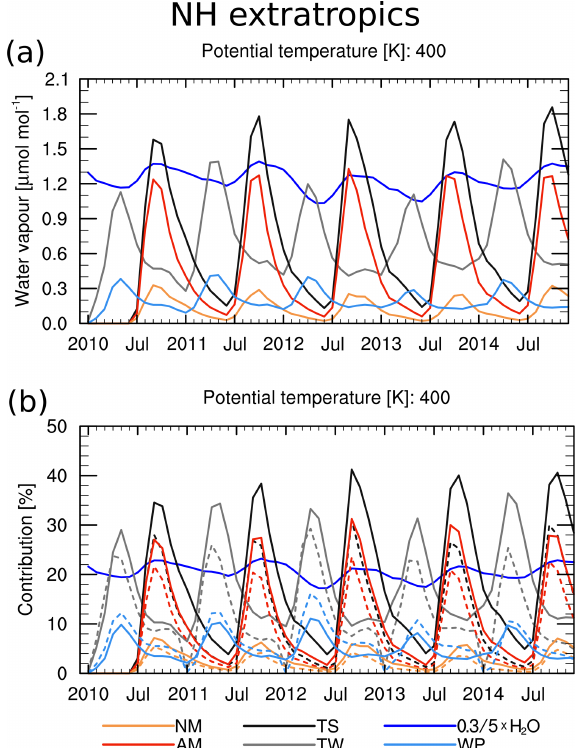
Figure 7. (a) Time series of the H 2 O mean mixing ratios from the different source regions and water vapour (all in µmolmol − 1 , total H 2 O scaled by × 0 . 3 to fit the same scale as the regional tracers). The time series are calculated over the region 50–70 ◦ N at 400K for the source regions TS (black), TW (grey), WP (light blue), AM (red) and NM (orange). Total water is shown in blue. (b) Time series of the contribution of the mass (dashed) and H 2 O (solid) tracers for the different regions averaged over 50–70 ◦ N at 400K. (Total H 2 O scaled by × 5, where 1% equals 1µmolmol − 1 .) Colour coding as in (a) .